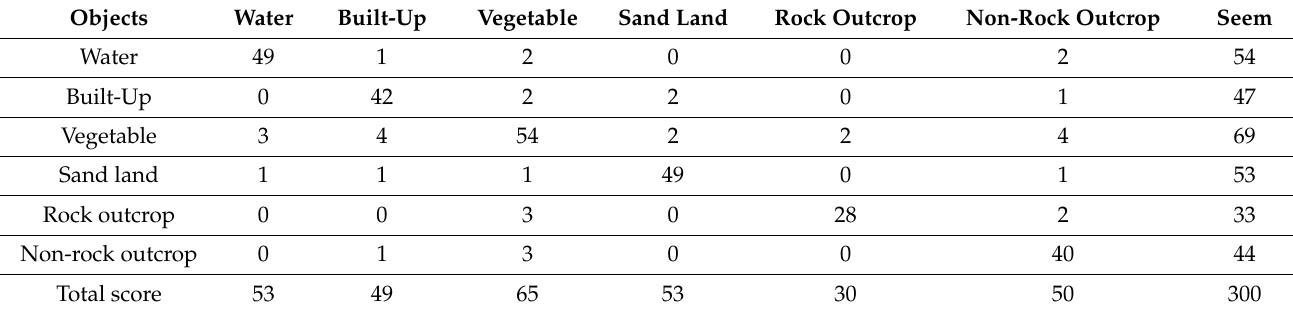
Table 7. Assessment Accuracy.